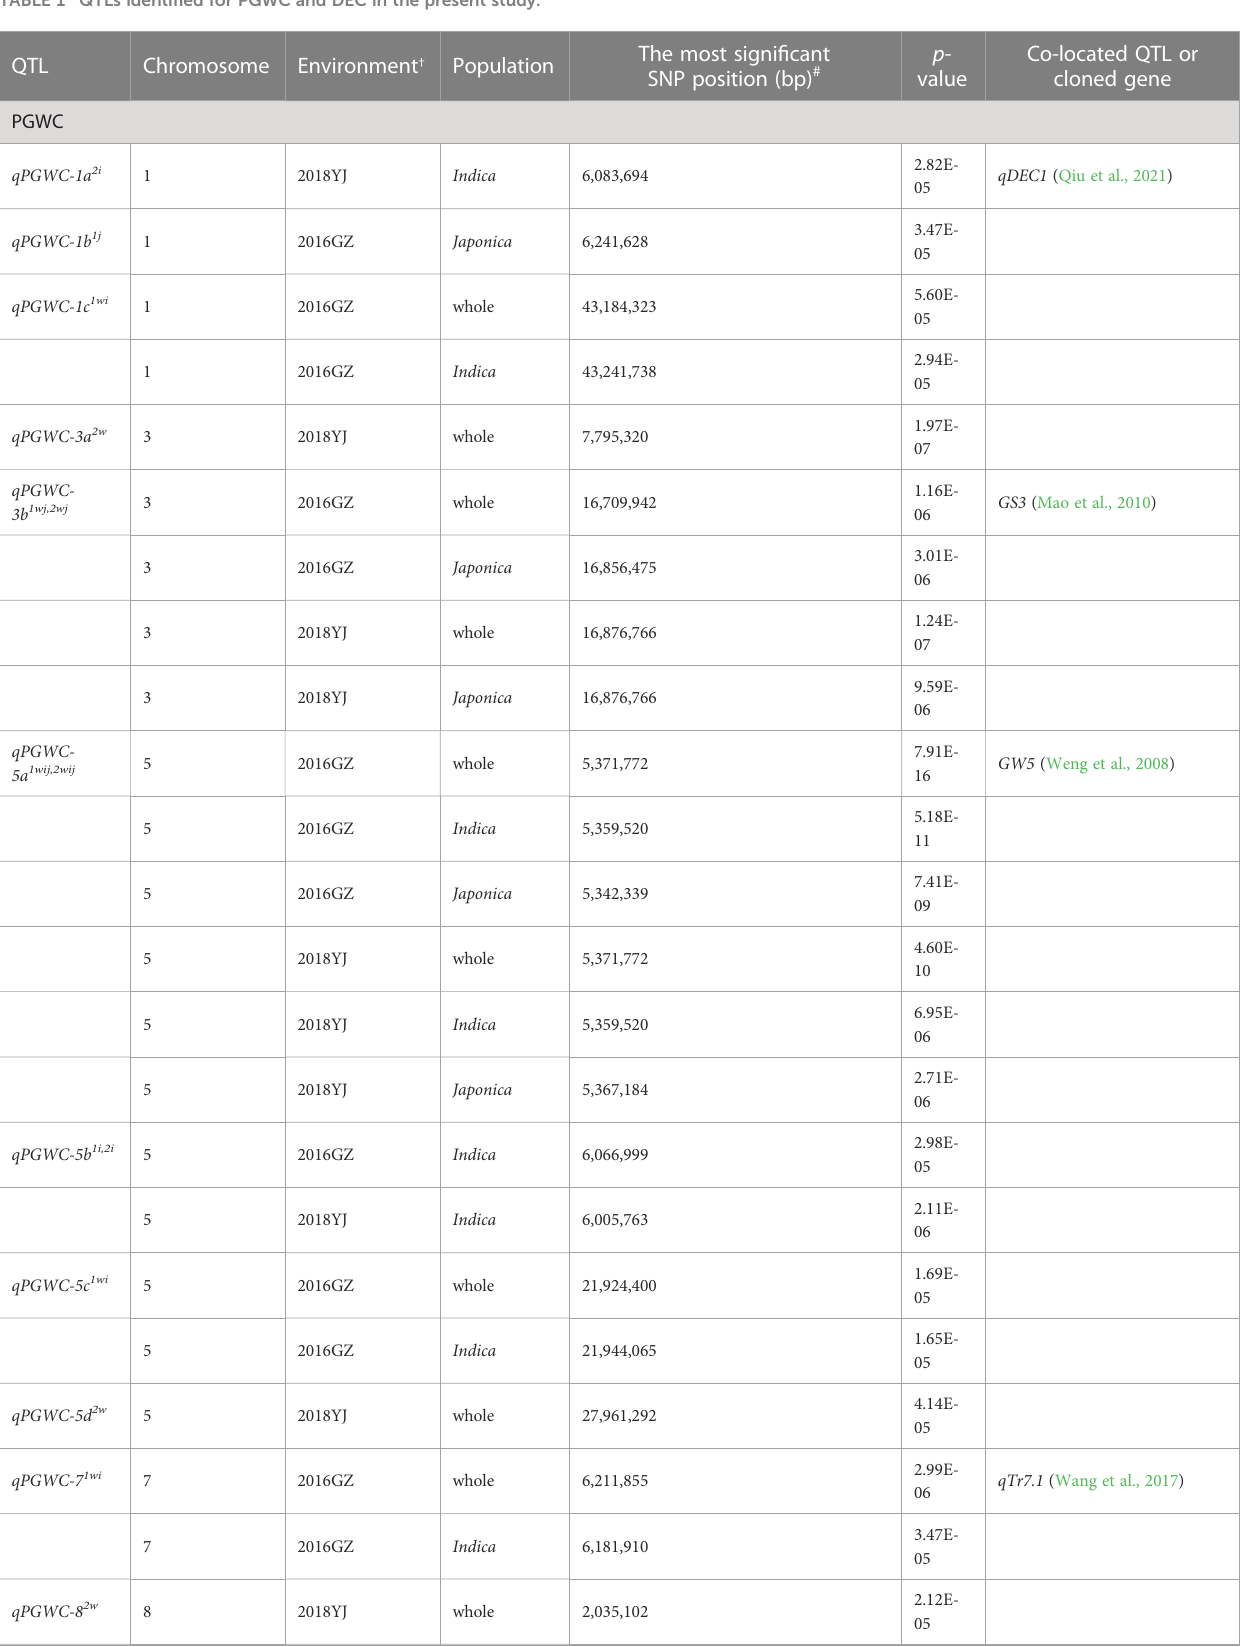
TABLE 1 QTLs identi fi ed for PGWC and DEC in the present study.